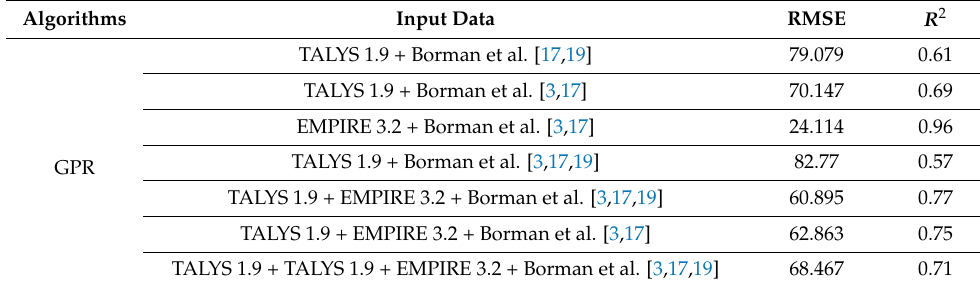
Table A3. Feature Selection by Recursive Feature Elimination for EXP + CEP cross-section using Gaussian process regression (GPR), random forest (RF) and support vector machine (SVM). Exper- imental dataset (EXP) includes experimental data from Borman et al. [17], Abboud et al. [18] and Kanda et al. [20], and crude estimation property (CEP) input includes EMPIRE 3.2 and TALYS 1.9 data from Luo and Jiang [3] and TALYS1.9 data from Naik et al. [19] are used as input. The machine learning model with R 2 closed to 1 and lowest RMSE is highlighted in